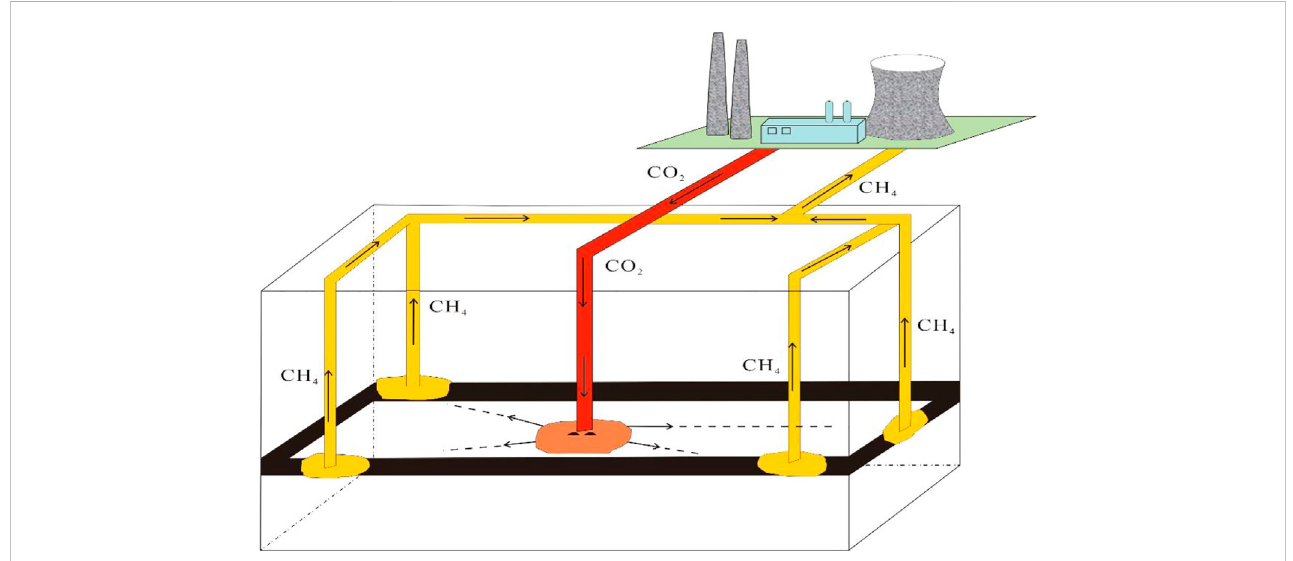
FIGURE 8 Schematic diagram of CO 2 sequestration and enhanced coal measure gas recovery.